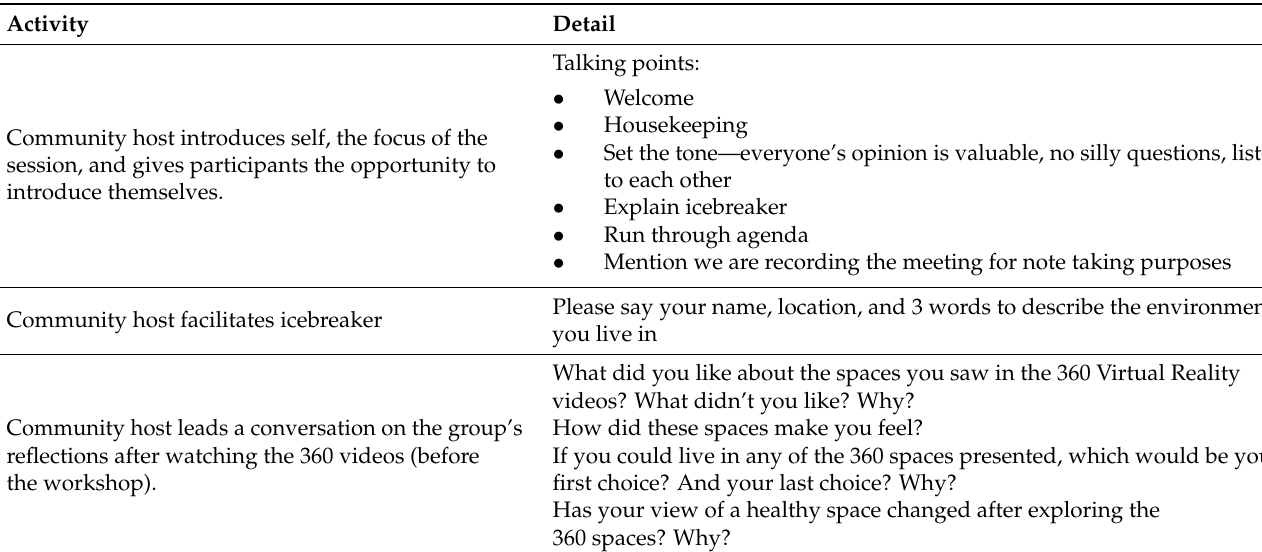
Table A1. Focus group facilitation